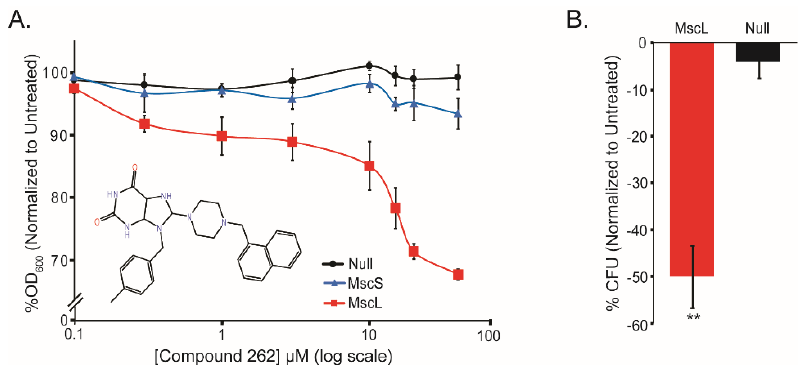
Figure 2. Compound 262 affects both the growth and viability of E. coli cultures in an MscL-dependent manner. E. coli MJF455 ( Δ MscL and Δ MscS) bacterial strain are shown. For the expression of MscL (red) and MscS (blue), the pb10d expression vector (black) was used. ( A ) Growth inhibition in the presence of increasing concentrations of compound 262 is shown as the percentage of growth (OD 600 ), normalized to untreated cultures. The structure of compound 262 is shown as an insert. Error bars show the standard error of the mean (SEM) (n = 3). ( B ) The percent reduction in CFU’s normalized to untreated samples after overnight treatment with 40 µM compound 262 (n = 4). ** p < 0.005 by a 2-tailed, homoscedastic t -test.